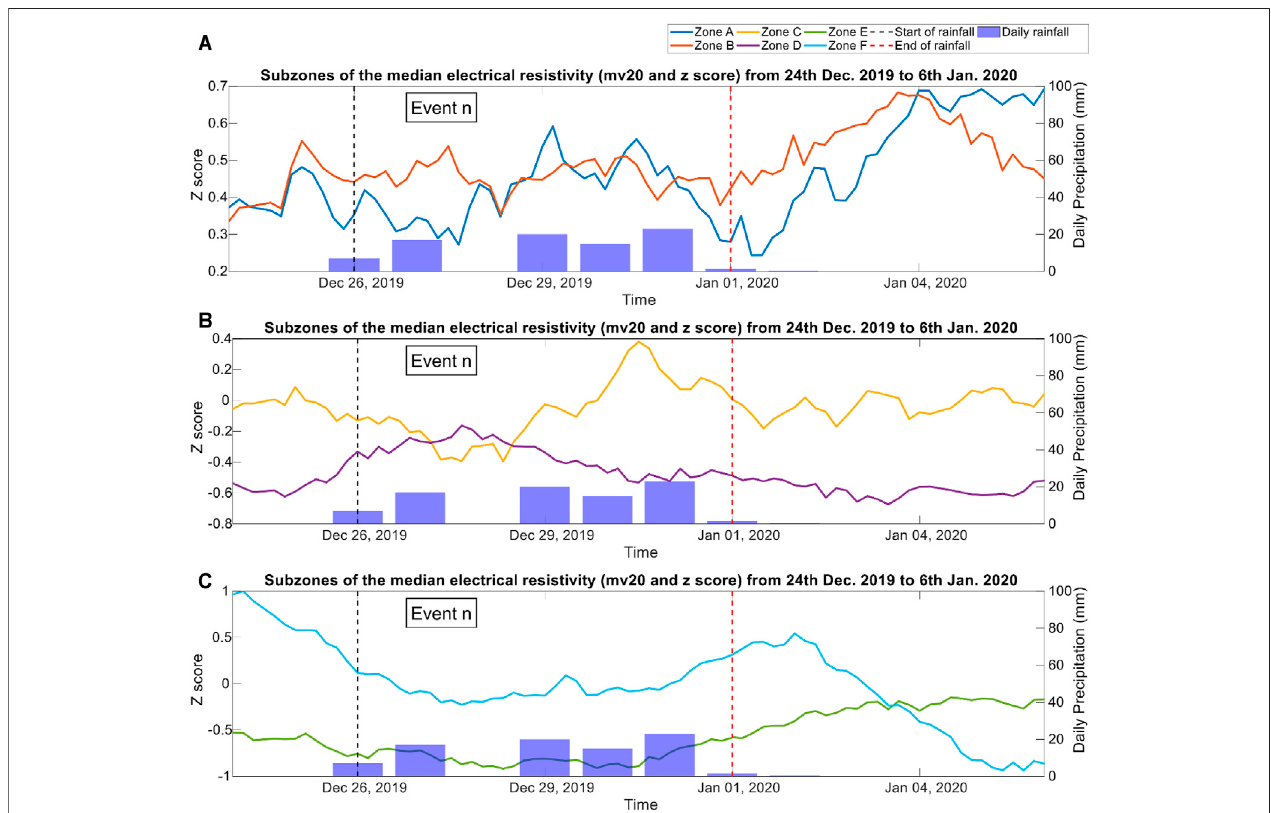
FIGURE 10 | Z-score of the MEER time series for the short-duration precipitation event (Event n ). Moving average for 20 measurements of the MEER curves: (A) Zones A and B, (B) Zones C and D, and (C) Zones E and F.